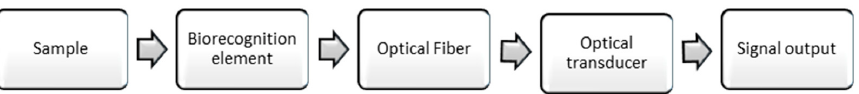
Diagnostics 2019 , 9 , x FOR PEER REVIEW Figure 2. Block diagram of the general flow of the signal of FOBS. Figure 2. Block diagram of the general flow of the signal of FOBS.